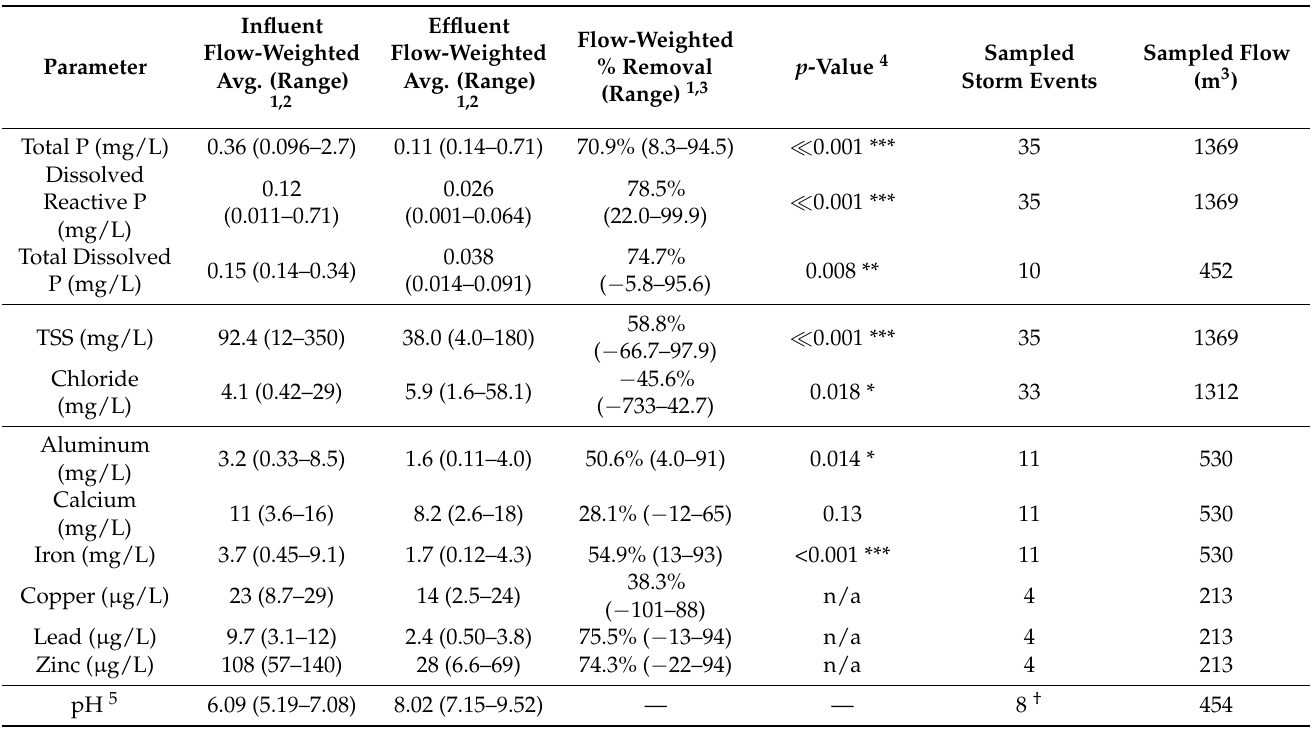
Table 2. Flow-weighted characterization of water quality and percent removal for nutrients, solids, and metals from influent stormwater and effluent